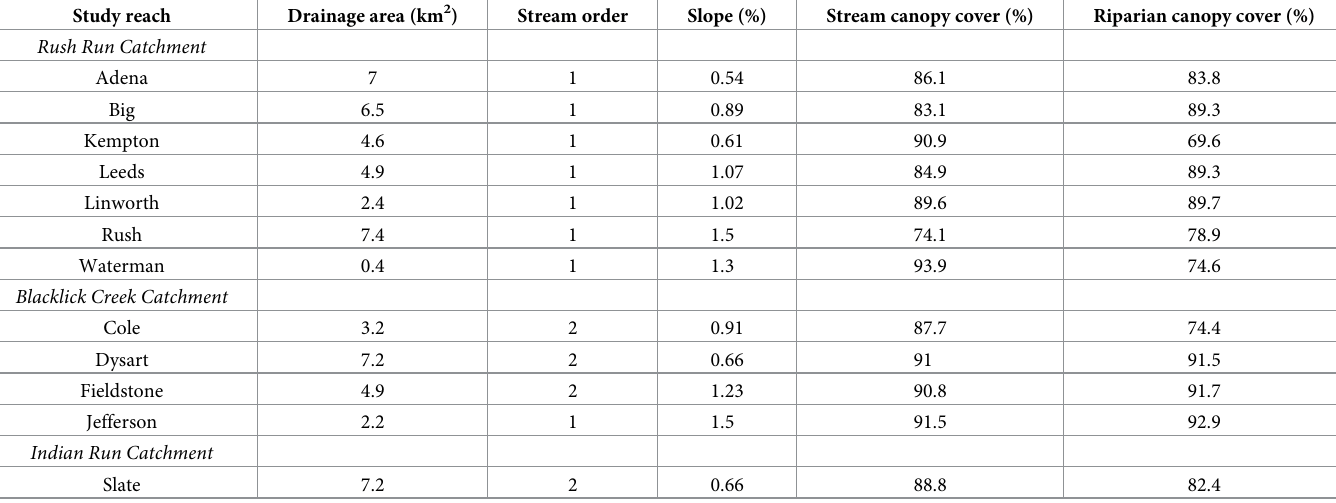
Table 2. Study reach